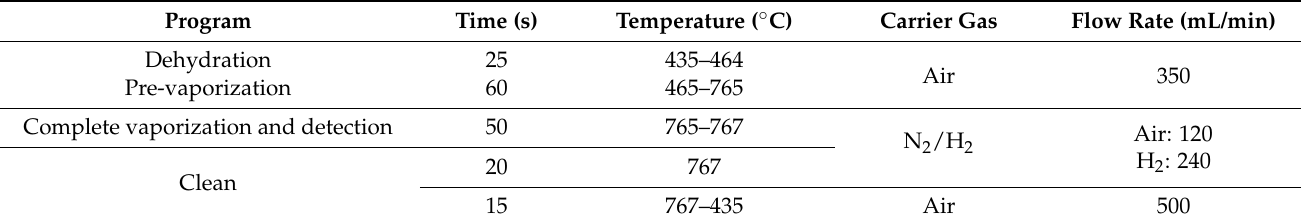
Table 3. Operating parameters of the SS-ETV-AAS.